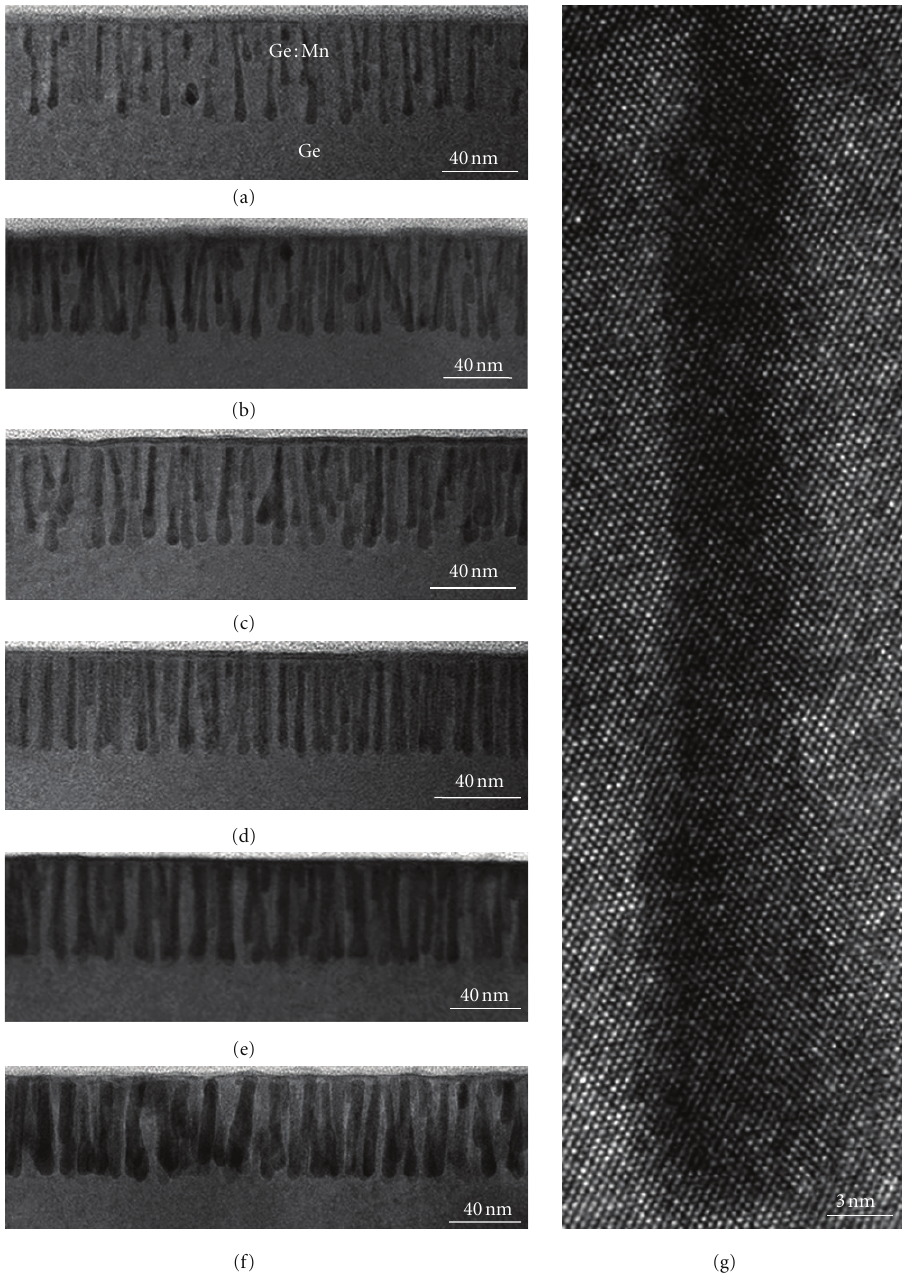
Figure 7: Cross-sectional TEM images of Ge 1 − x Mn x grown at 70 ◦ C: (a) x = 0 . 025, (b) x = 0 . 04, (c) x = 0 . 045, (d) x = 0 . 055, (e) x = 0 . 07, (f) x = 0 . 12. (g) HRTEM image of a coherent nanocolumn. Reproduced from [14]. Copyright ©2010, Elsevier